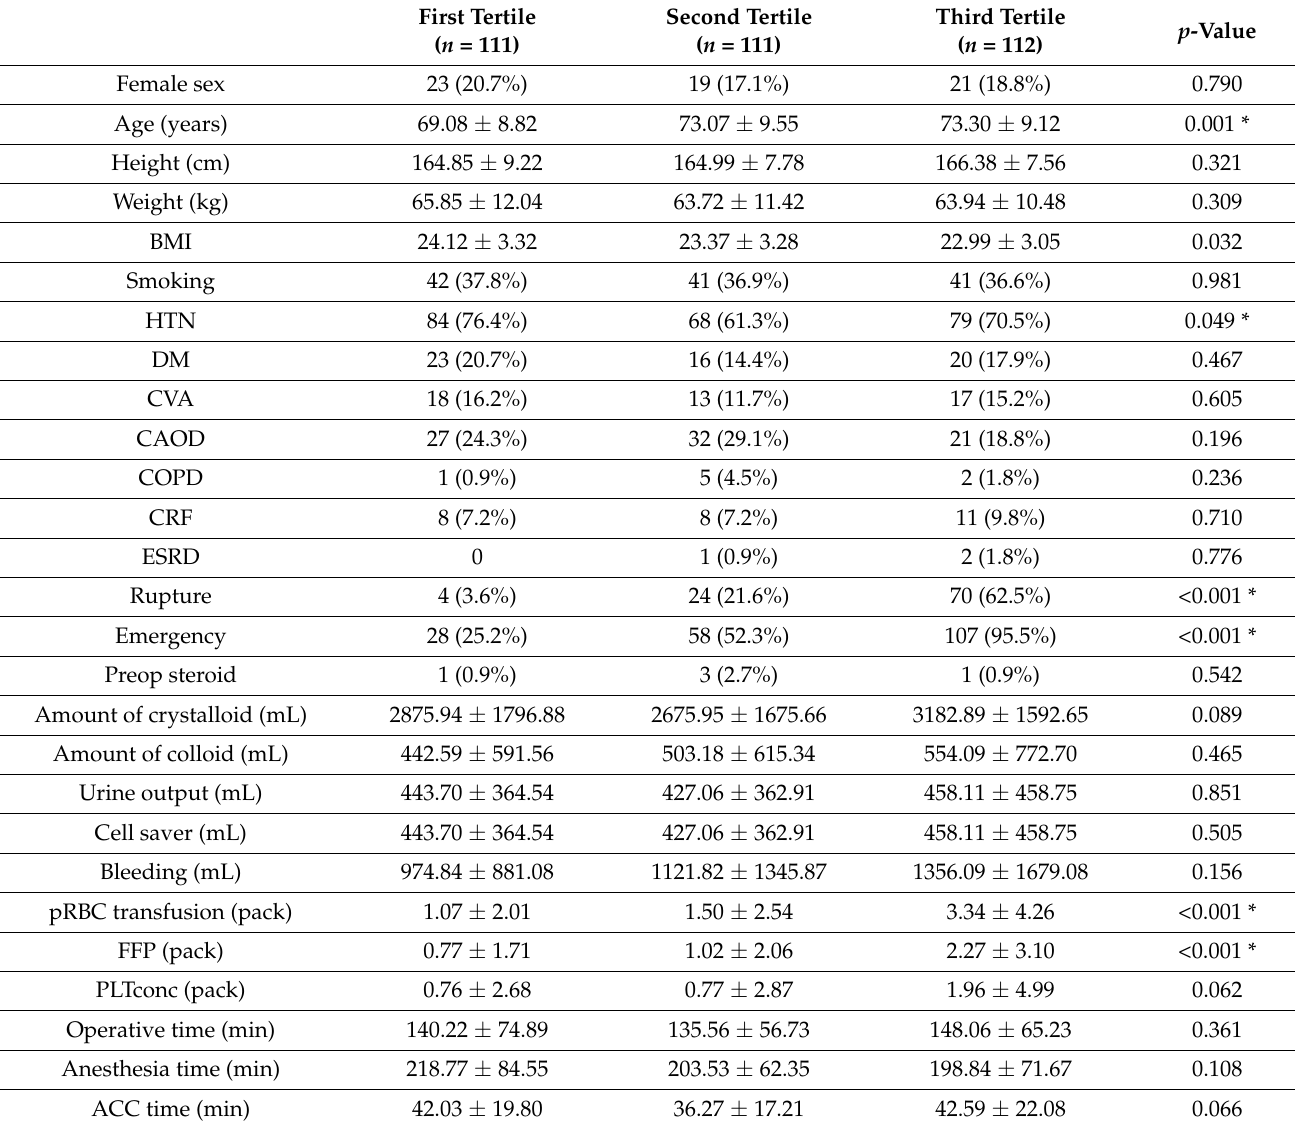
Table 2. Baseline characteristics and operation related data across three NLR tertiles.